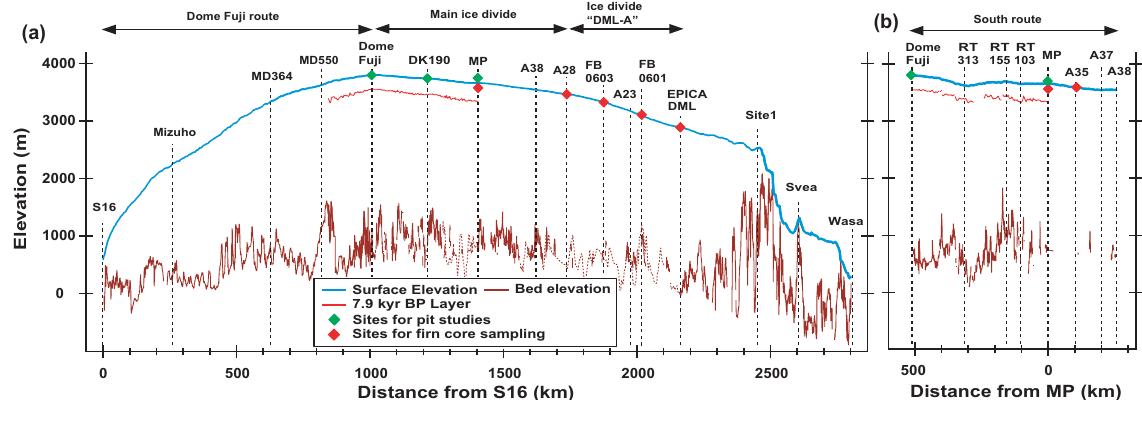
Fig. 2. Cross section of the ice sheet along the JASE traverse routes. (a) The main ice divide route (see red trace in Fig. 1). (b) The south routes (see blue traces in Fig. 1). Abscissas show (a) distance along the traverse from S16 toward Wasa Station and (b) distance from MP along the south routes. The vertical exaggeration is 200 times. Vertical dashed lines show the location of major sites. Surface elevation data (blue curves) are based on the digital elevation model of Bamber et al. (2006). A shallow isochrone within the ice sheet is shown as a red profile based on analysis of the radar sounding data. It is dated as the 7.9 ± 0.5kyrBP layer (see text). Bed elevation was derived from the radar sounding data. For some locations where the bed signal was undetected in the JASE traverse, ice thickness data from an earlier airborne radar sounding (Huybrechts et al., 2009) is shown as a thin dotted profile. Sites with symbols indicate sites of pit studies and/or firn core sampling (see